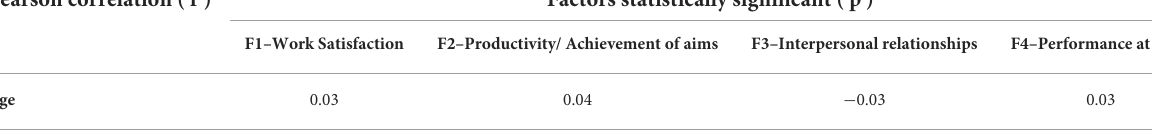
TABLE 2 Statistical significance of the age variable in relation to individual factors. Pearson correlation ( r )